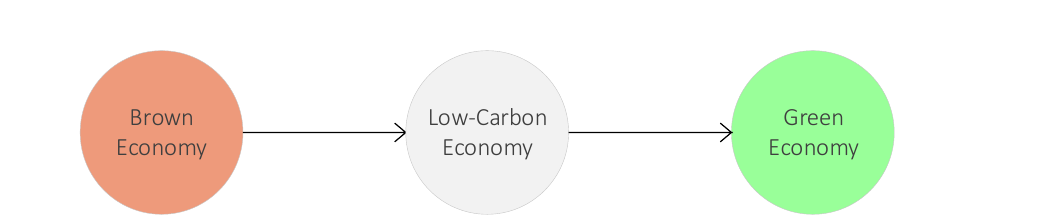
Figure 4. Economic transit ion by colour codes.